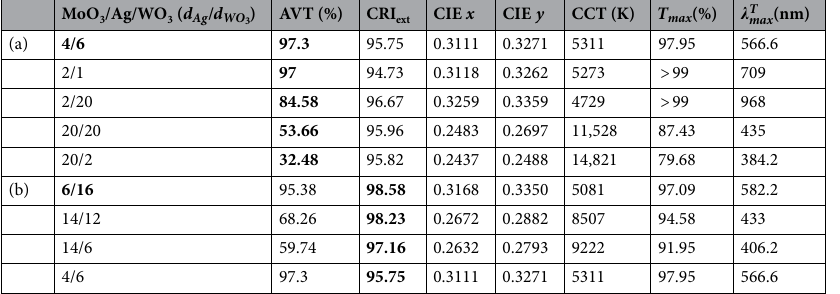
Table 1. Optical parameters of the transparent contact structure at different thickness values. CRI ext , CIE x and y, CCT, T max and (cid:31) T max values for MoO 3 /Ag/WO 3 (10/ d Ag / d WO 3 nm) transparent contact structure for certain thicknesses according to various (a) AVT and (b) CRI ext distributions. The d Ag / d WO 3 values given in bold are the optimal values with the highest AVT in the a section and, the highest CRI ext in the b